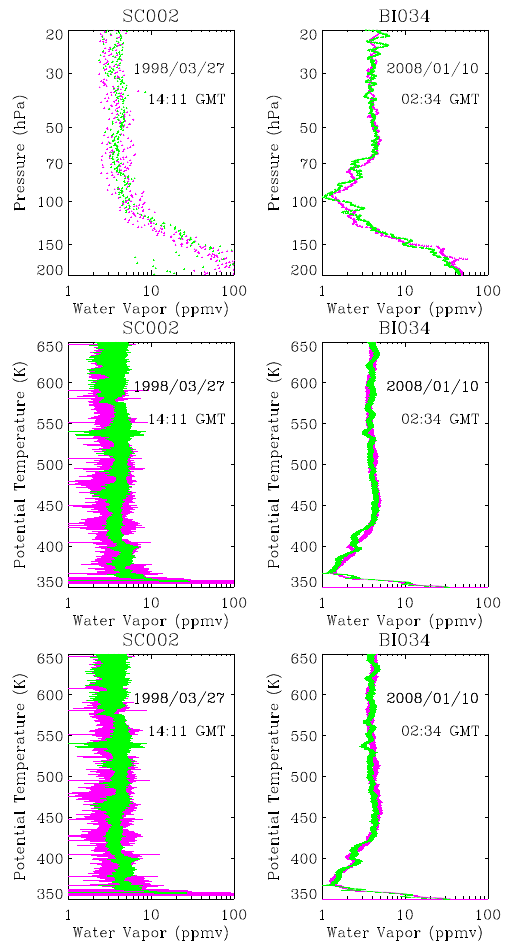
Fig. 2. Examples of water mixing ratio (ppmv) profiles taken at (left) San Crist´obal (SC) in March 1998 and (right) Biak (BI) in January 2008. Ascending (green) and descending (purple) profiles are superposed to visualise the phase delay associated with the upward and downward sonde motion. (Top) raw data, (middle) same data projected on isentropic coordinates, and (bottom) same with phase correction applied. See Appendix for the data processing procedure and the derivation of uncertainties shown in horizontal bars.